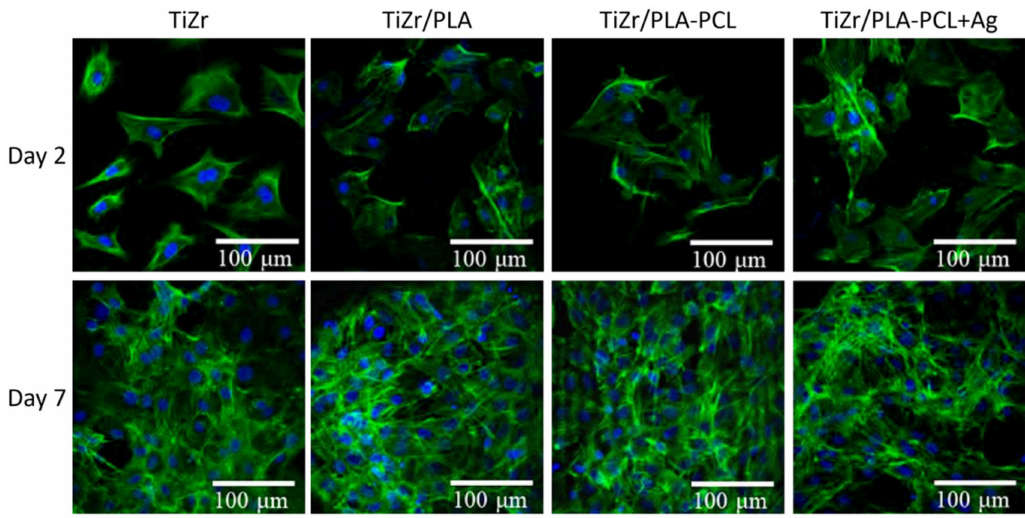
Figure 8. E ff ect of MC3T3-E1 cells adhesion and spreading (nuclei – blue colour, actin cytoskeleton – green colour) on bare TiZr and coated TiZr samples after 2 and 7